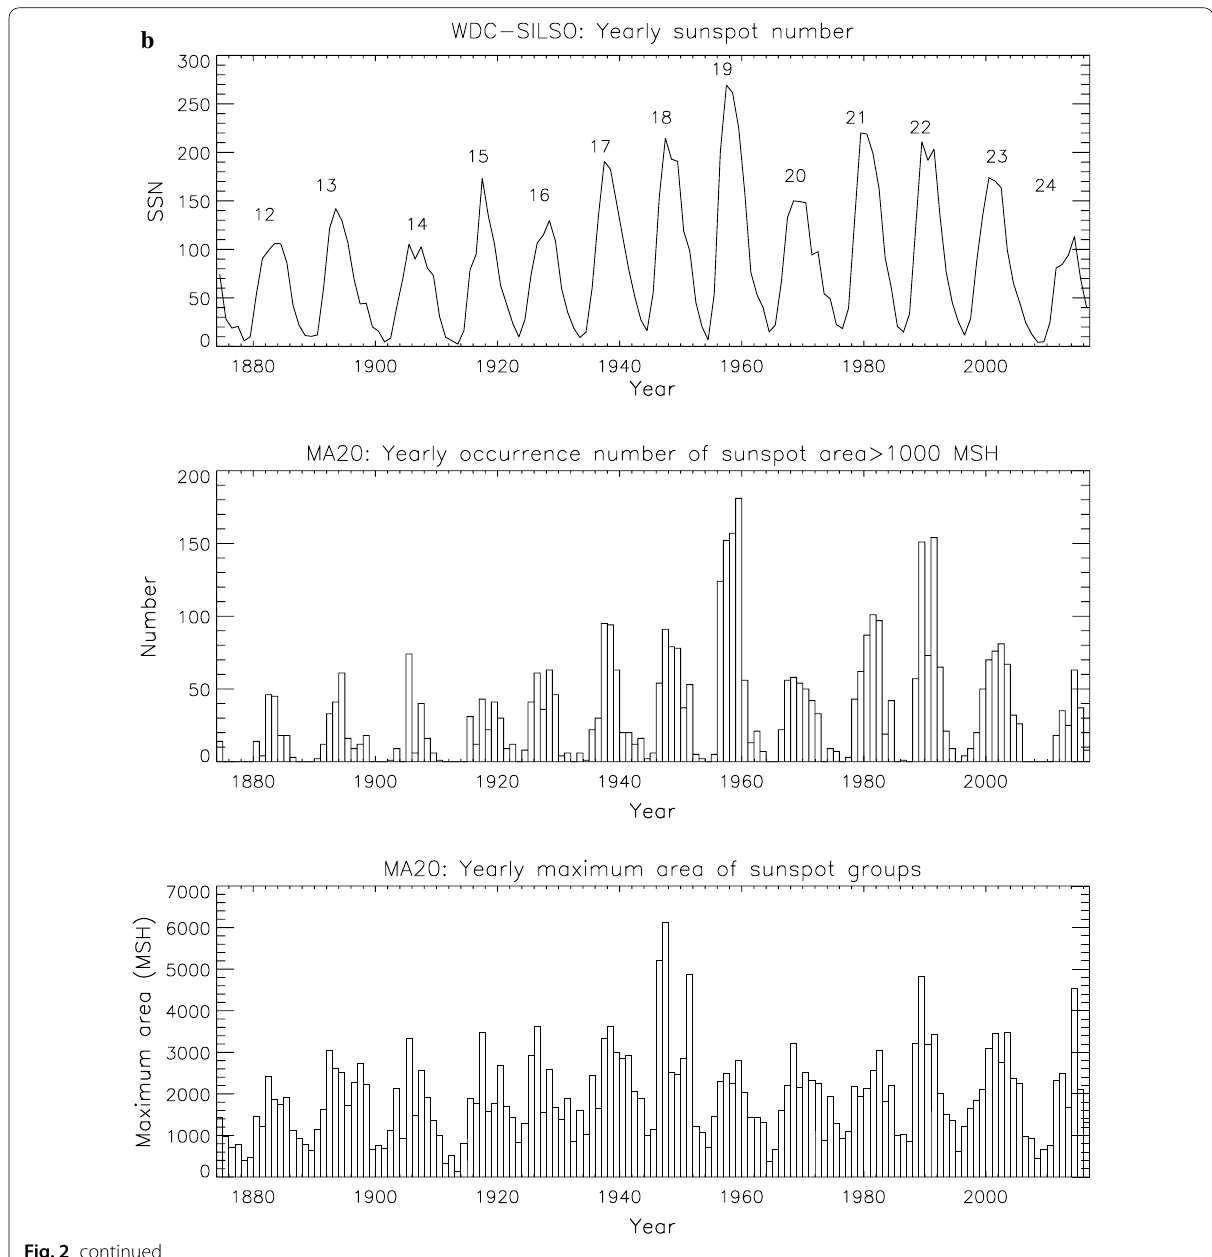
The sunspot group (no. 12 in Table 1∕no. 11 in Table 2, 14 March 1989∕16 March 1989. This sunspot group pro- NOAA active region no.10486) had its maximum area duced multiple large SXR flares including the maximum flare of X15 on 6 March 1989. The magnetic storm of the minimum Dst of 589 nT caused by interplanetary − CMEs in association with these large flares is the larg- est storm since the Dst index was initiated (Lakhina and Tsurutani 2016). A power blackout occurred in Quebec, Canada, during this storm (Boteler 2019).